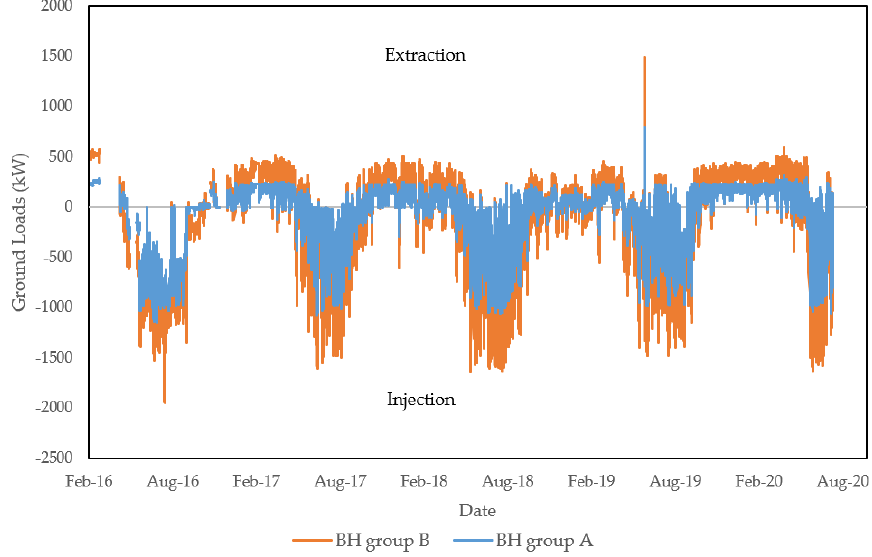
Figure 3. Measured loads of the BHE.